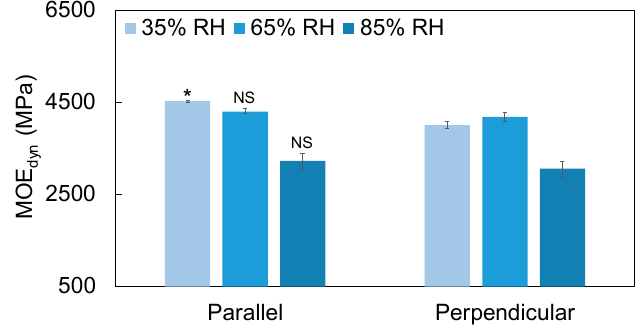
Figure 5. Dynamic modulus of elasticity (MOE dyn ) of Medite Tricoya ® MDF samples at different relative humidity levels measured by the acoustic resonance method. Error bars represent 95% confidence intervals for the means. * Significant differences between parallel and perpendicular samples as determined by two-sample t-test at the 0.05 level. NS, non-significant.